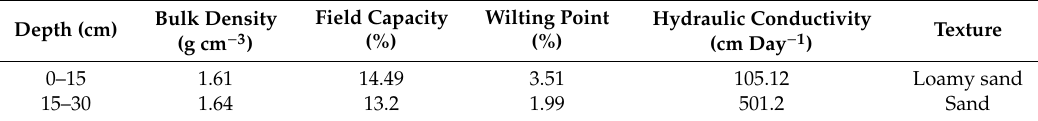
Table 2. Physical properties of the soil used in the